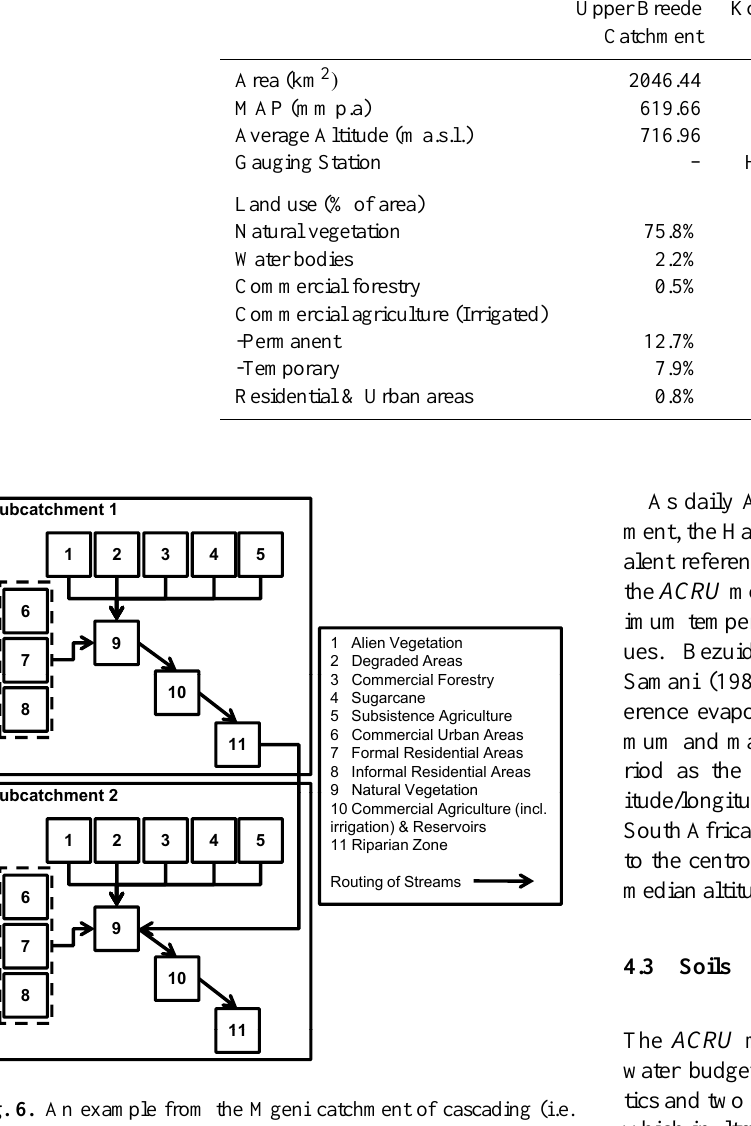
Fig. 6. An example from the Mgeni catchment of cascading (i.e. routing) of flows between subcatchment and land use units within each